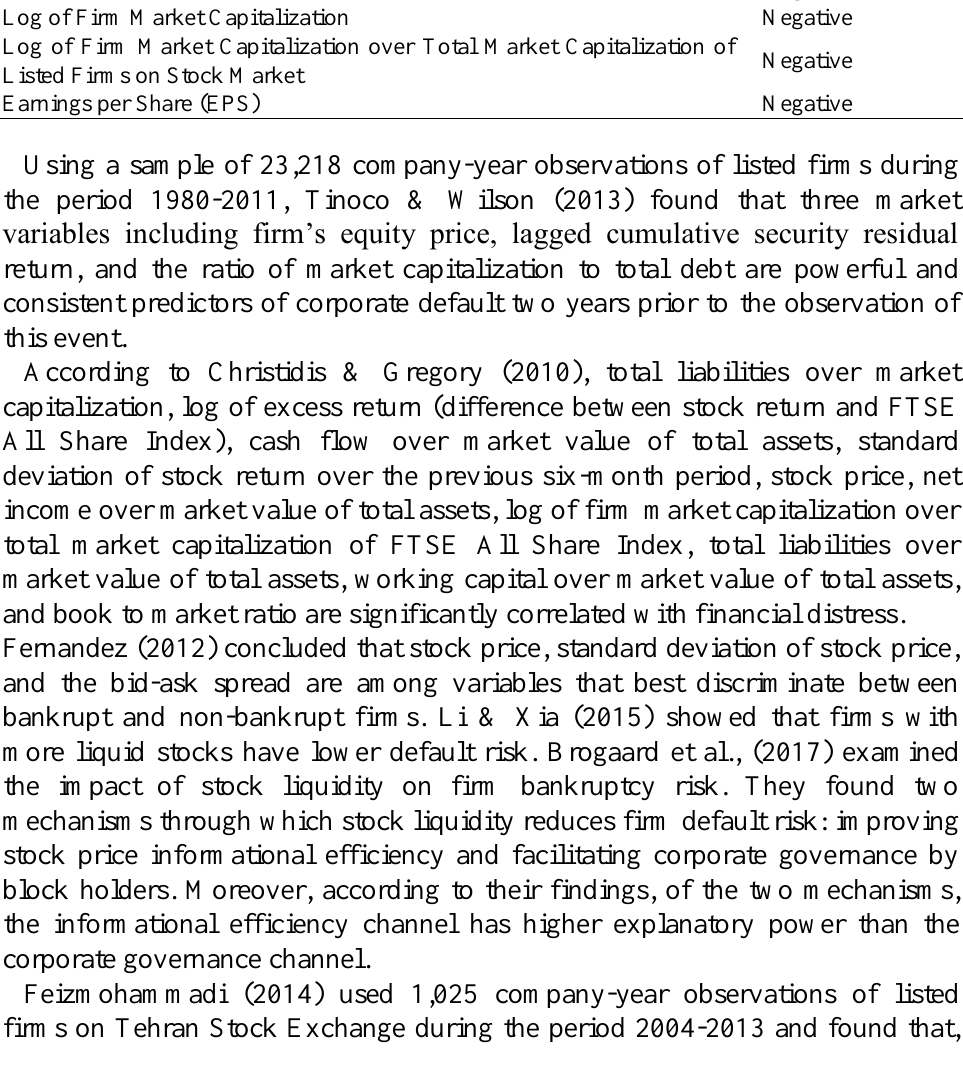
Table (2). Market Variables Affecting Corporate Default Market Variable Expected Sign Stock Return Negative Difference between Stock Return and Market Return (Excess Stock Return over Market Return) Standard Deviation of Stock Return Positive Stock Price Gap Positive Stock Price Trend Positive Market to Book Ratio Negative Log of Firm Market Capitalization Negative Log of Firm Market Capitalization over Total Market Capitalization of Listed Firms on Stock Market